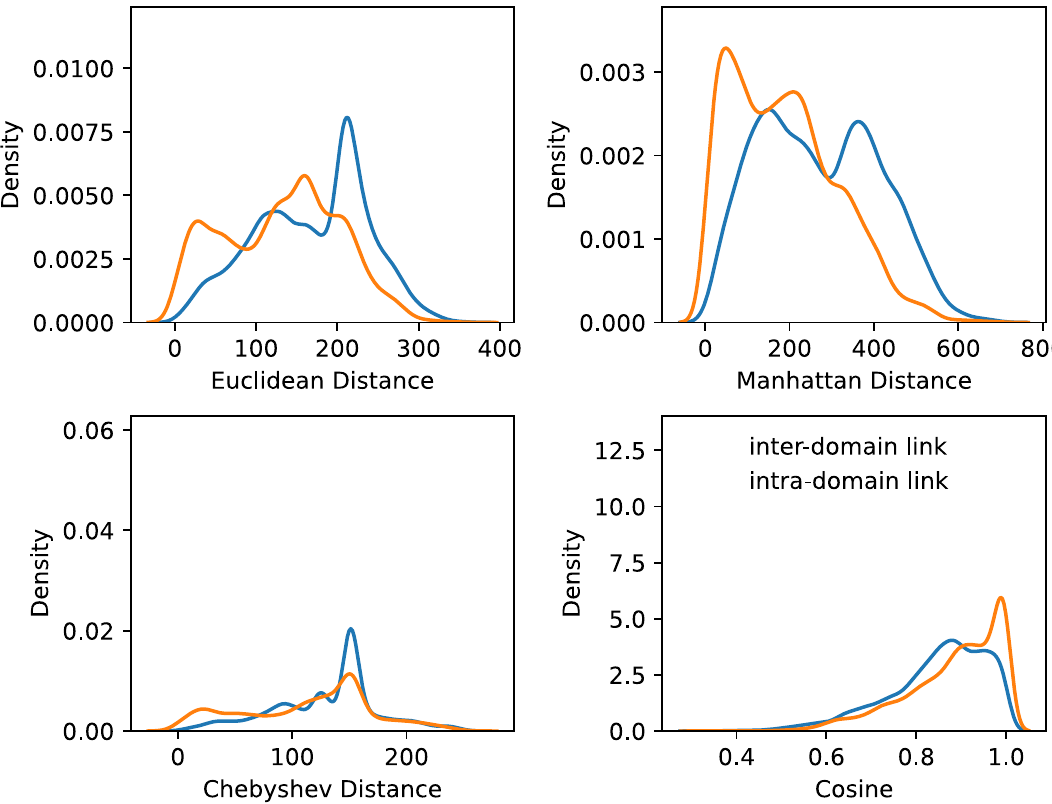
Figure 5. The vector distance statistic histogram of IP addresses at both ends of IP links belong to two different